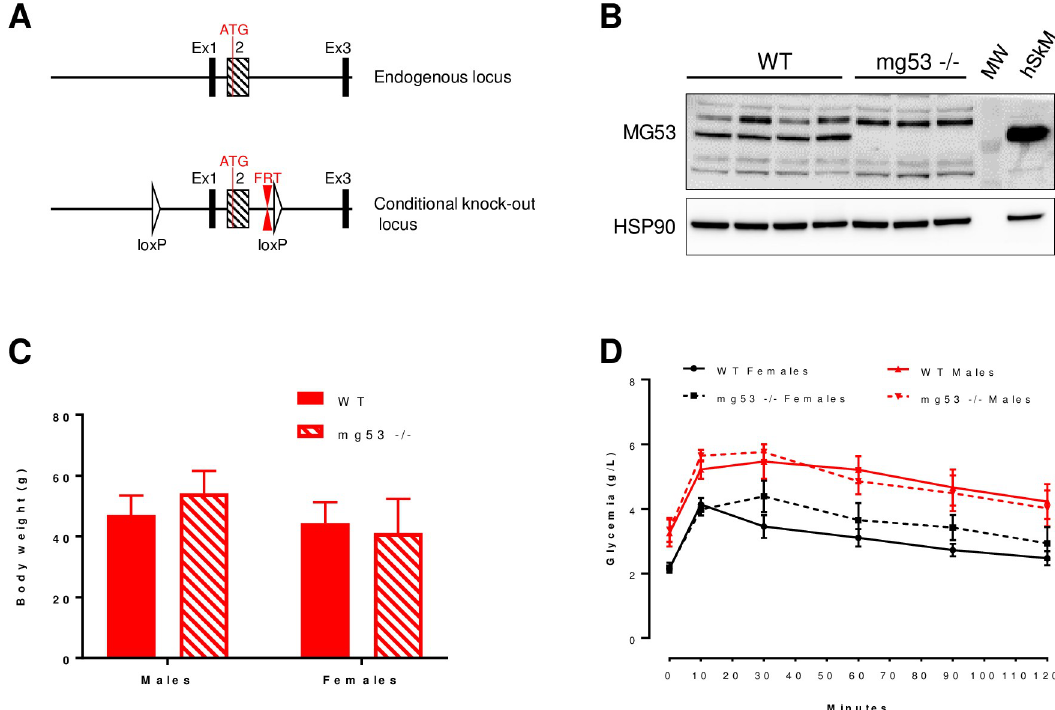
Fig 5. mg53 gene deficiency does not affect high fat diet-induced obesity and glucose intolerance. Panel A: targeting strategy to engineer mg53 -/- mice. Panel B: western blot analysis of MG53 expression in both wild type and KO mice. MW: molecular weight marker. 10 μ g of total protein lysate from human skeletal muscle was used as positive control. Panel C: Total body weight in both males and females wild-type and mg53 KO mice after 16 weeks of high fat diet. Panel D: An oral GTT was performed in both male and female mice (wild-type vs. KO mice) after 16 weeks of high fat